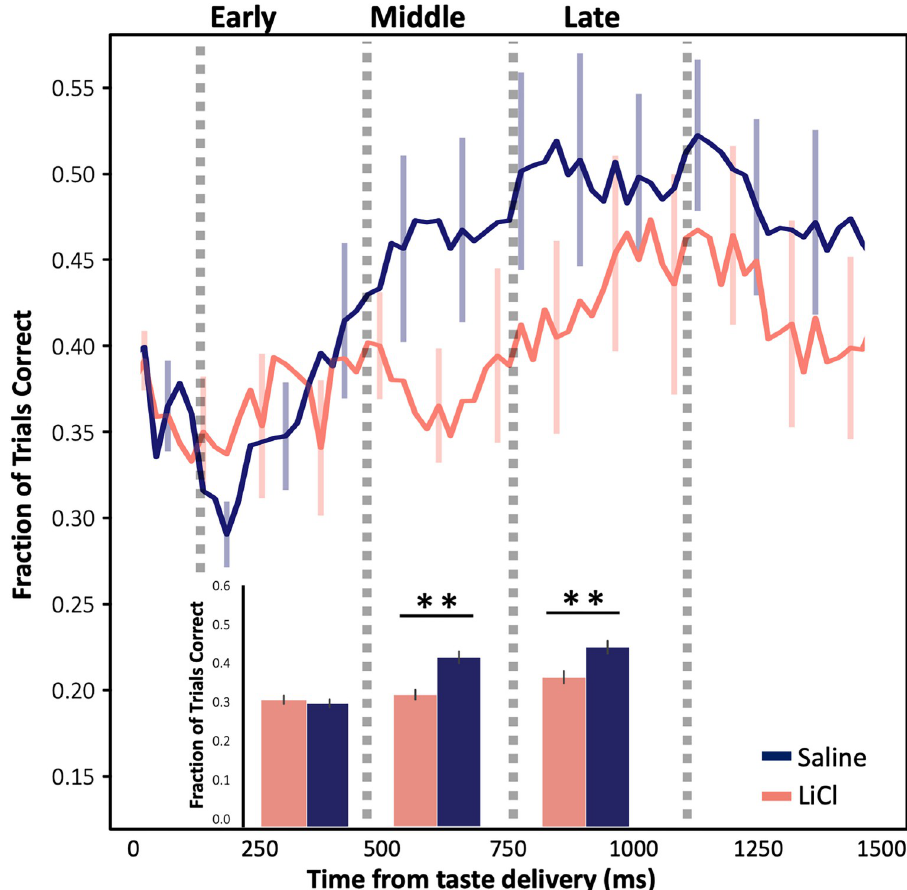
Fig 5. LiCl administration reduces taste discriminability in neural ensembles. The time course of trials in which the taste could be correctly identified by ensemble firing, according to LDA, shows reduced discriminability of responses when an animal is sick (LiCl; coral, n = 174) in comparison to when they are healthy (saline; purple, n = 136). The vertical dashed lines delineate approximate epochal boundaries, as defined in previous research; collapsed into these epochs (bottom bars, the effect of illness only becomes significant within the middle (400–700 ms) and late (800–1,100 ms) epochs post taste delivery ( �� p < 0.01; pairwise t test with Bonferroni correction). The error bars represent SEMs. Data underlying this figure can be found in S4 Data. LDA, linear discriminant analysis; LiCl, lithium